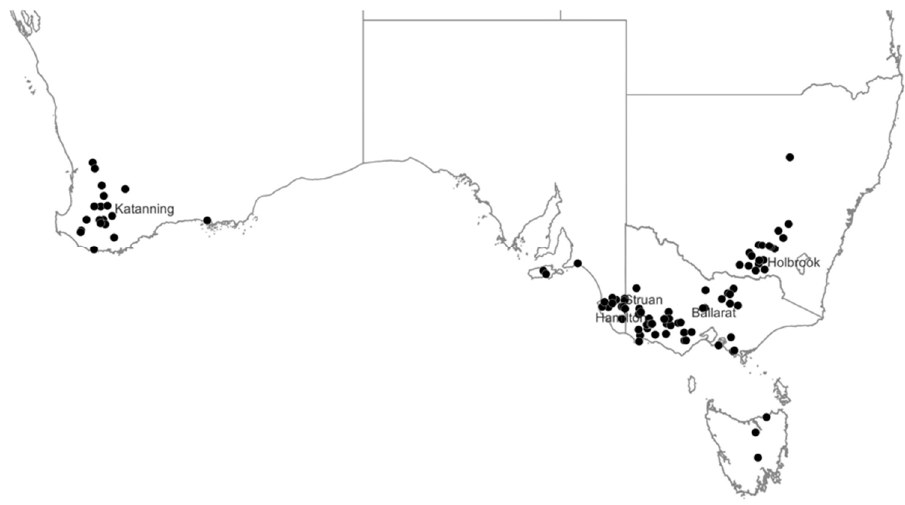
Figure 1. Location of participants of benchmarking surveys (black circle; n = 95) and workshops ( n = 5) across southern Australia.